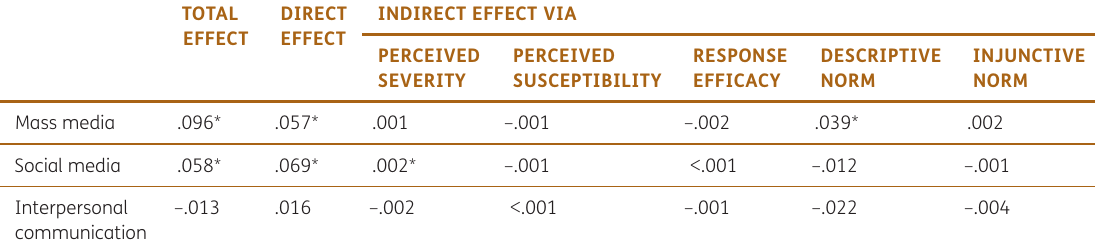
Table 8 Total Effects, Direct Effects and Indirect Effects on Physical Distancing Behavior in the School Sample. Note : N =